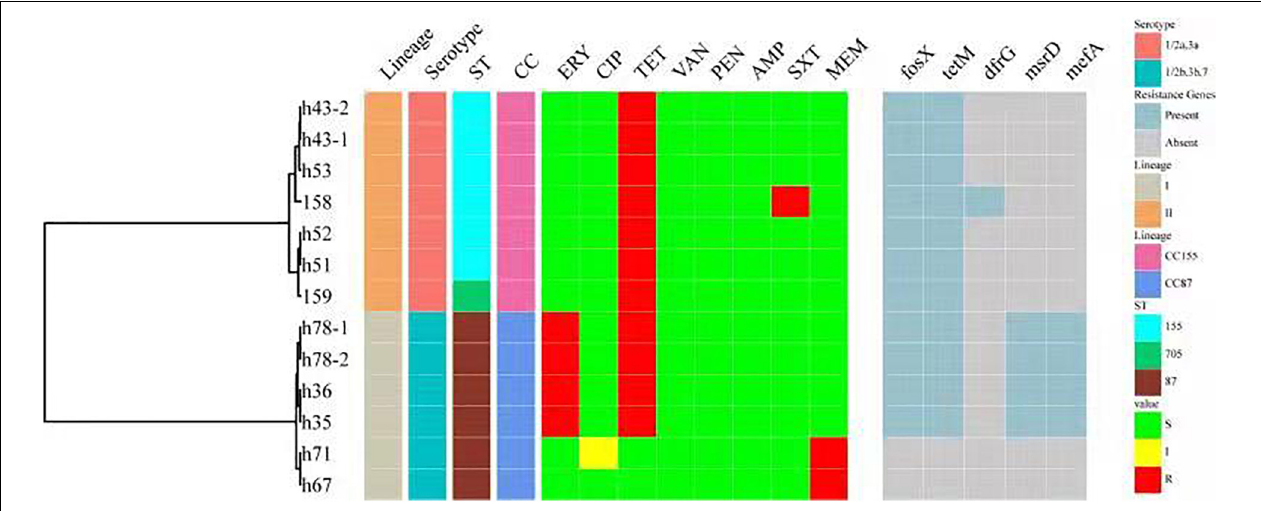
FIGURE 5 | A summary figure showing the lineage, serogroup, ST, CC, and the antimicrobial resistance phenotypes and genotypes of 13 resistant L. monocytogenes. ST, MLST type; CC, clonal complex; ERY, erythromycin; CIP, ciprofloxacin; TET, tetracycline; VAN, vancomycin; PEN, penicillin; AMP, ampicillin; SXT, trimethoprim-sulfamethoxazole; MRP, meropenem. Antibiotic resistance genes include tet M (encoding resistance to TET), drf G (encoding resistance to SXT) and msr D and mef A (encoding resistance to